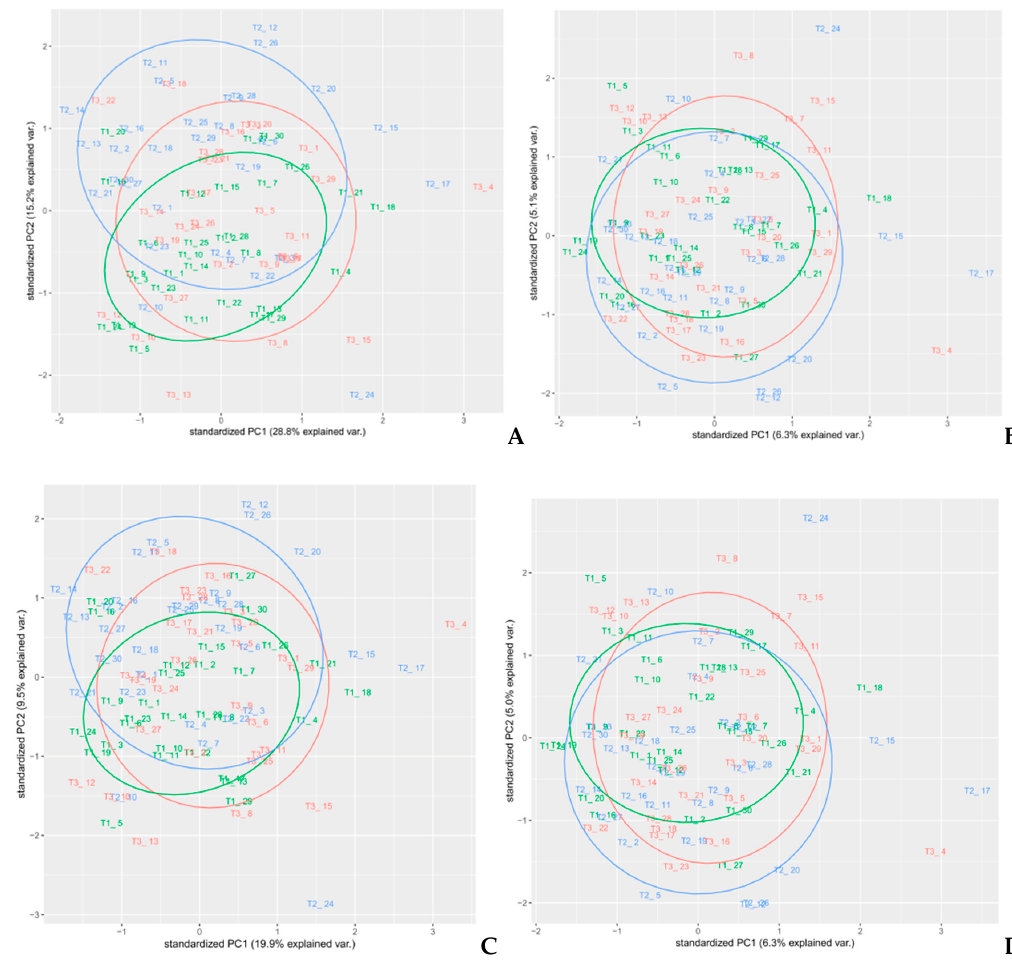
Figure 7. PCA analysis on spectra pre-treated with Savitzky–Golay derivatives. ( A ) D1 ( p = 1, n = 31, m = 1), ( B ) D2 ( p = 2, n = 31, m = 2), ( C ) D1 ( p = 3, n = 31, m = 1), and ( D ) D2( p = 3, n = 31, m = 2).